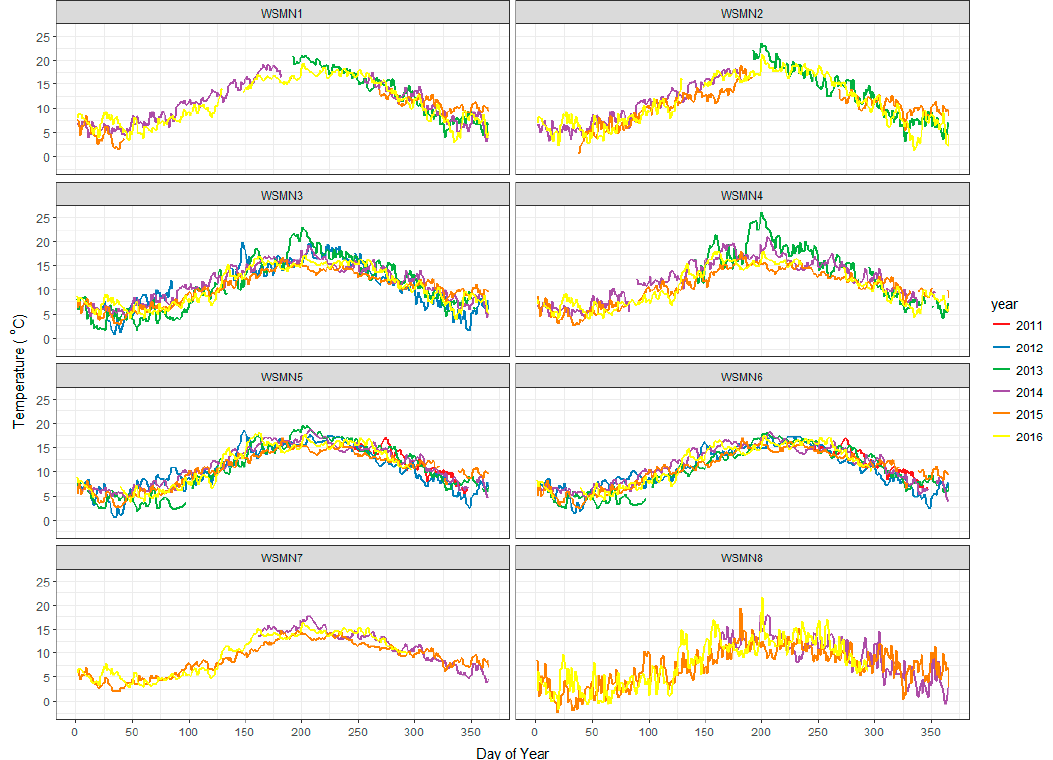
Figure 3. Time series of ST at 5 cm depth from the soil surface layer measured at the WSMN experimental sites from their individual installation dates to the present.